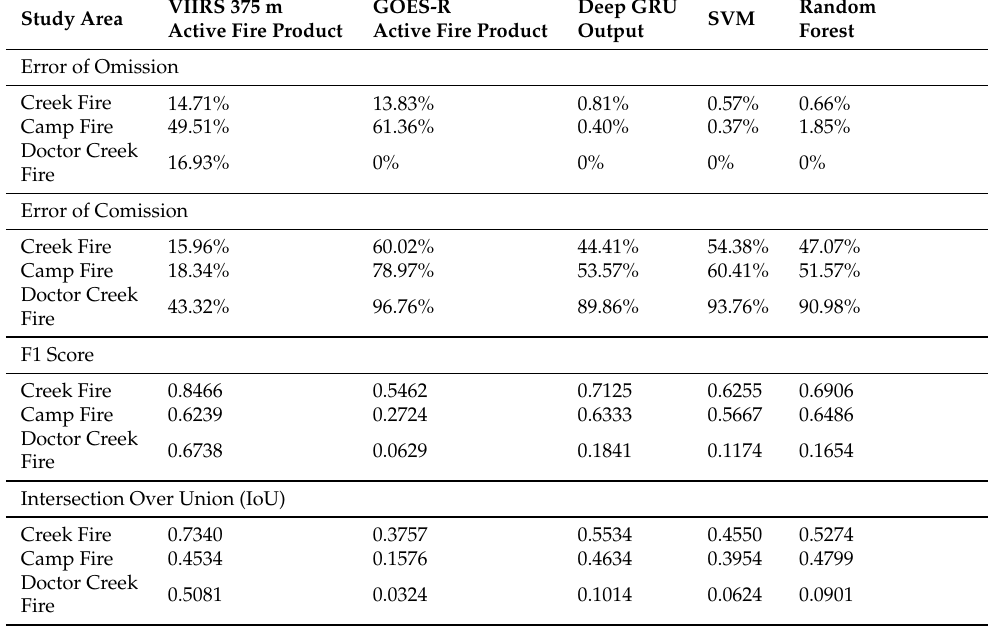
Table 5. Accuracy Evaluation on burned area mappings using VIIRS active fire product, GOES-R active fire product, output of proposed Deep-GRU network based on GOES-R images, output of Support Vector Machine (SVM) and Random Forest using GOES-R